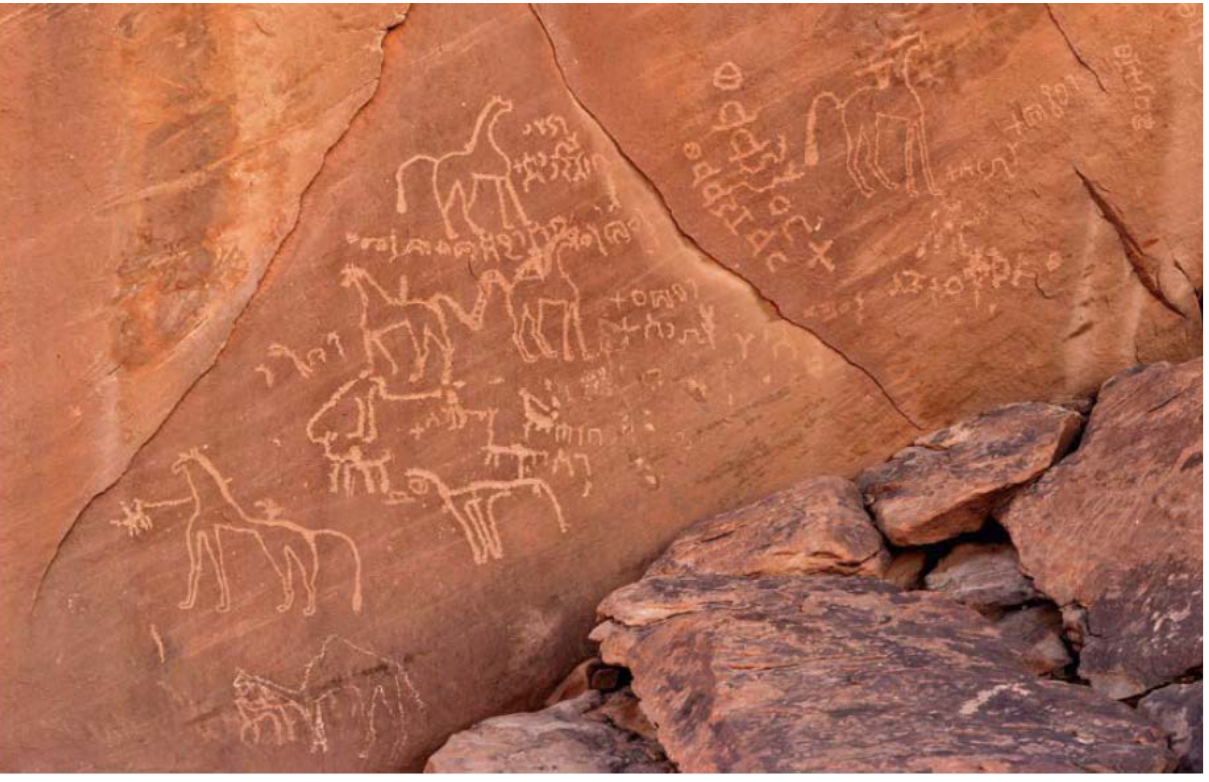
Figure 32. Horse petroglyphs occurring together with the Thamudic names of people, presumably their respective